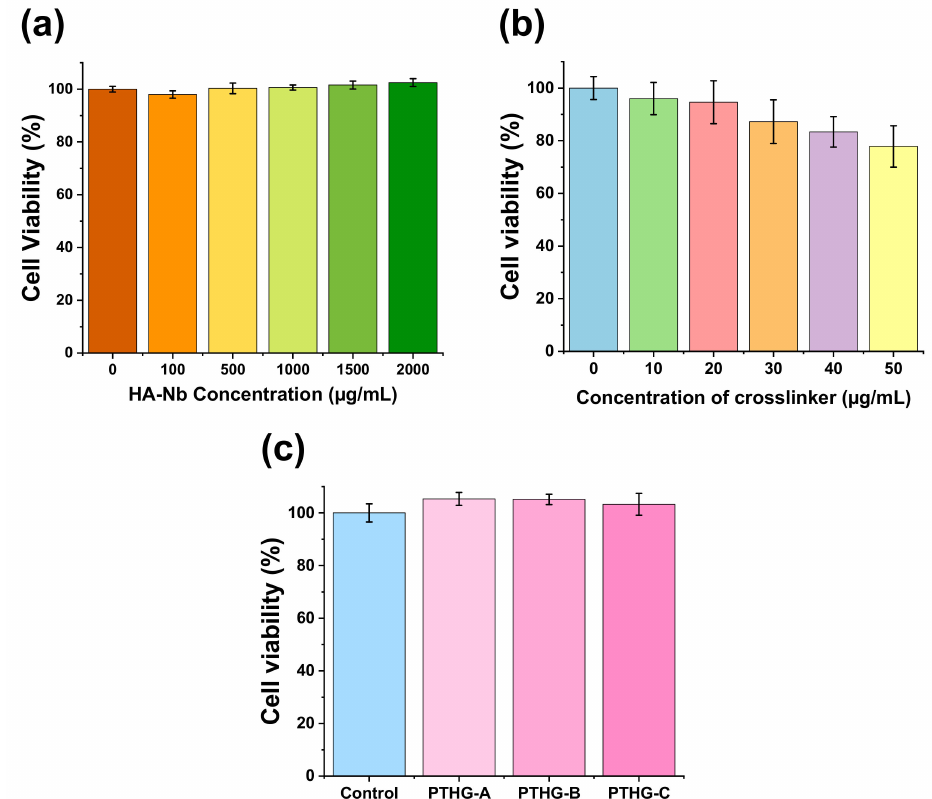
Figure 8. In vitro cytocompatibility of HEK-293 cells after treatment with ( a ) HA-Nb, ( b ) PEG-DTz, and ( c ) Hydrogels (PTHG-A, PTHG-B, and PTHG-C). Error bars showing standard deviation (n =